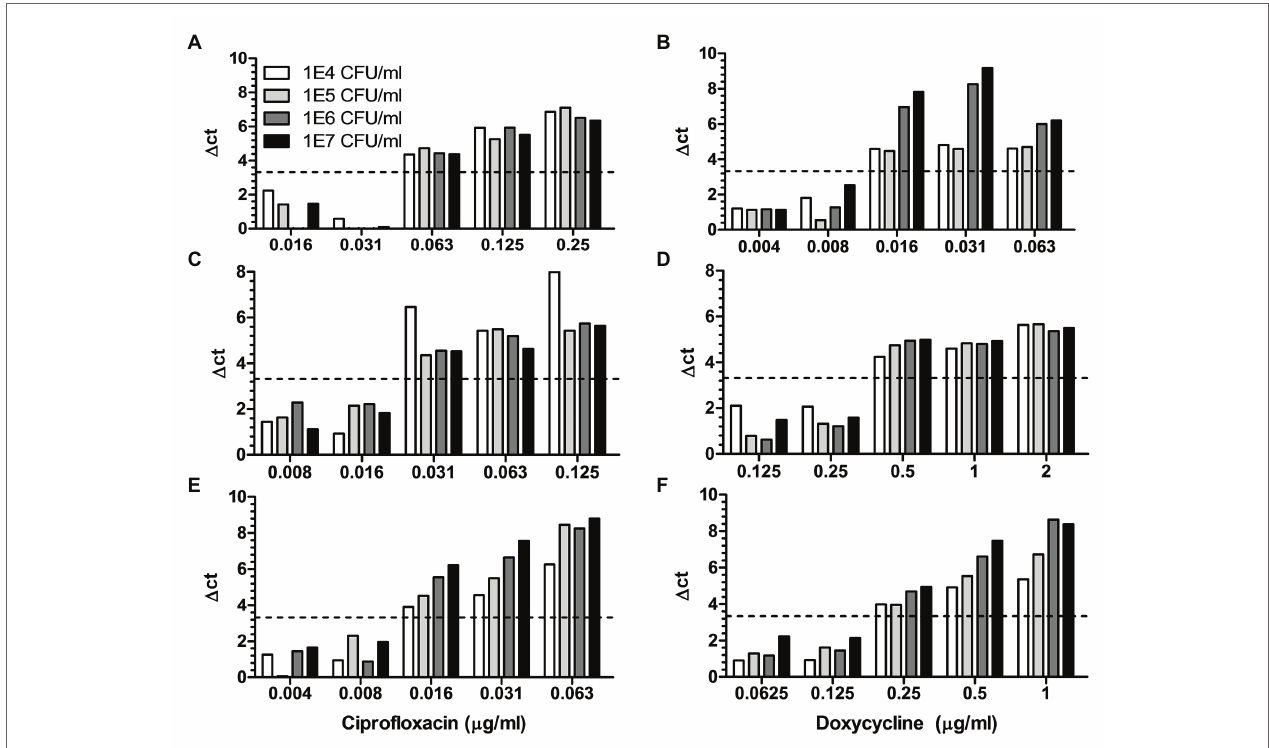
FIGURE 1 | Micro-Agar-PCR-test (MAPt) is applicable to a wide range of bacterial concentrations. Cultures of Bacillus anthracis (panels A,B ), Yersinia pestis (panels C,D ), and Francisella tularemia (panels E,F ), at various concentrations, were subjected to MAPt testing doxycycline and ciprofloxacin. The B. anthracis plates were incubated for 5 h and F. tularensis plates for 12 h at 37 ° C and Y. pestis plates for 8 h at 28 ° C. Following incubation the bacteria were harvested from the MAPt plate and subjected to qPCR quantification. Minimal inhibitory concentration (MIC) was determined, as described in materials and methods, by the thresholds of ∆ CT =